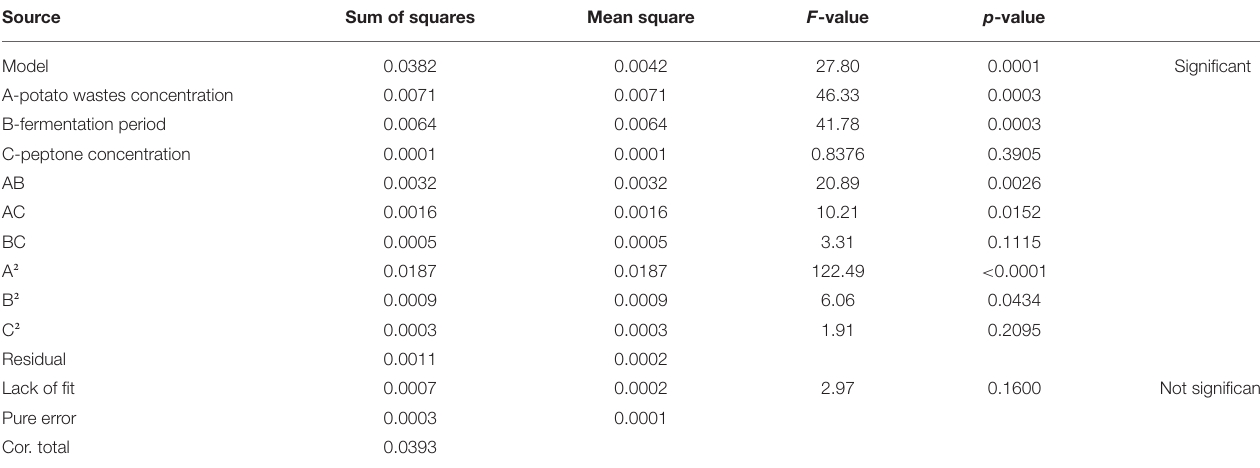
TABLE 5 | ANOVA for the entire quadratic model of response (2) concentration of biomass.